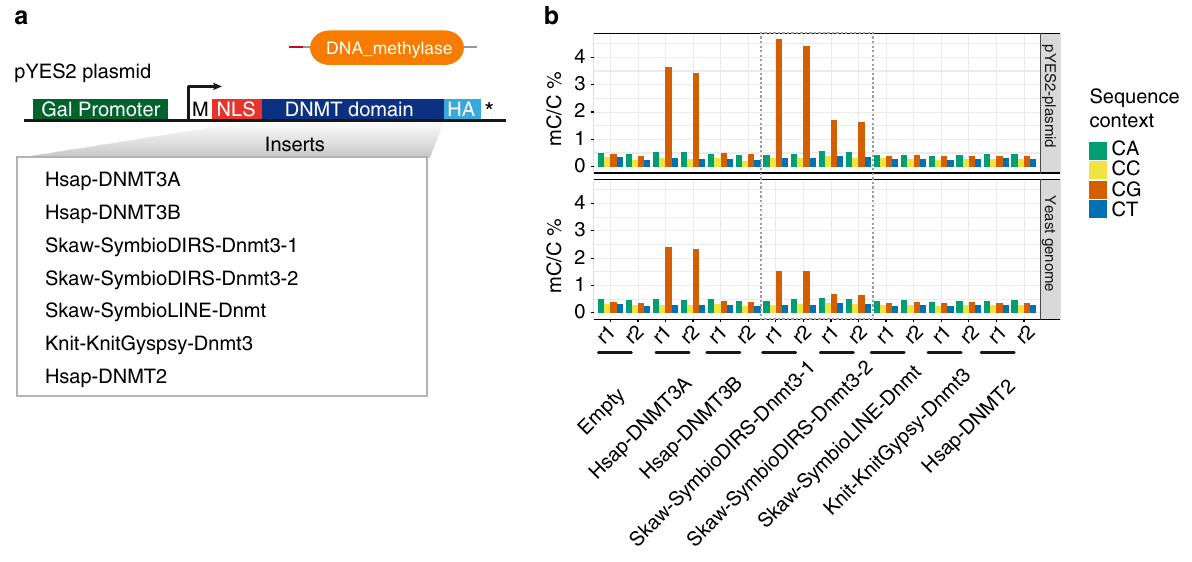
Fig. 5 De novo methylation of CGs by retrotransposon-encoded DNMTs. a Schematic representation of the pYES2 construct and the list of DNMT domain inserts tested. M starting methionine, NLS nuclear localisation signal, HA human in fl uenza hemagglutinin tag, Hsap Homo sapiens , Skaw S. kawagutii , Knit K. nitens . b Methylation induction in pYES2-DNMT-expressing yeast lines measured in duplicates (r1 and r2) as a percentage of mC calls against all Cs in each of the four dinucleotide sequence contexts. Independent measures of methylation levels reported for the episomal pYES2 construct and the native yeast genome. Data for the non-conversion for each experiment (spiked-in lambda genome) is in Supplementary Fig.